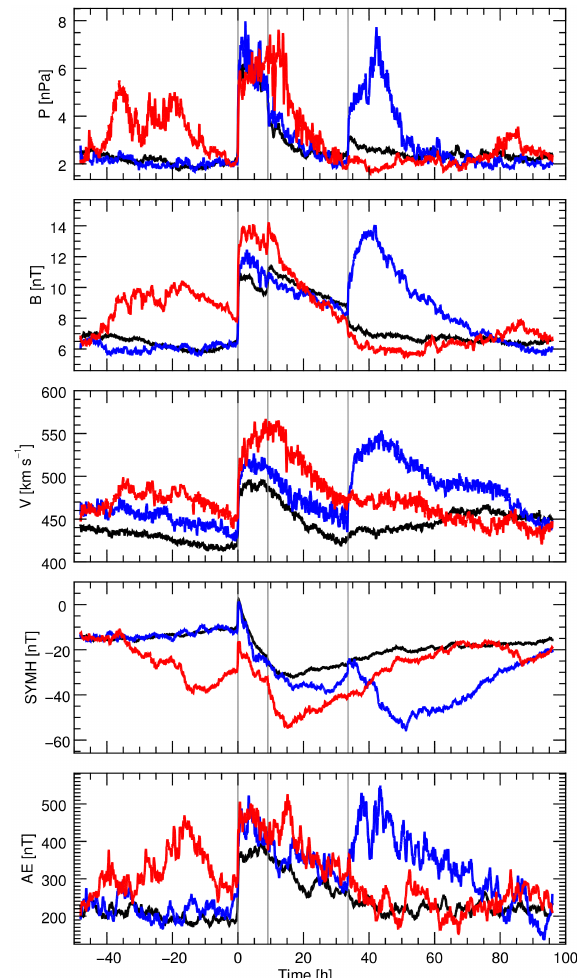
Figure 6. SEAs of three SW parameters ( B , P , V ) and two geo- magnetic indices (SYM-H and AE) for 306 ICMEs between 1996 and 2008. The three vertical lines are the epoch times indicating (respectively from left to right) the onset of the sheath, the onset of the ICME, and the end of the ICME. The different colors corre- spond to different subset of events: isolated events (black line, 187 events), first events (in blue, 34 events), and second events (in red, 34